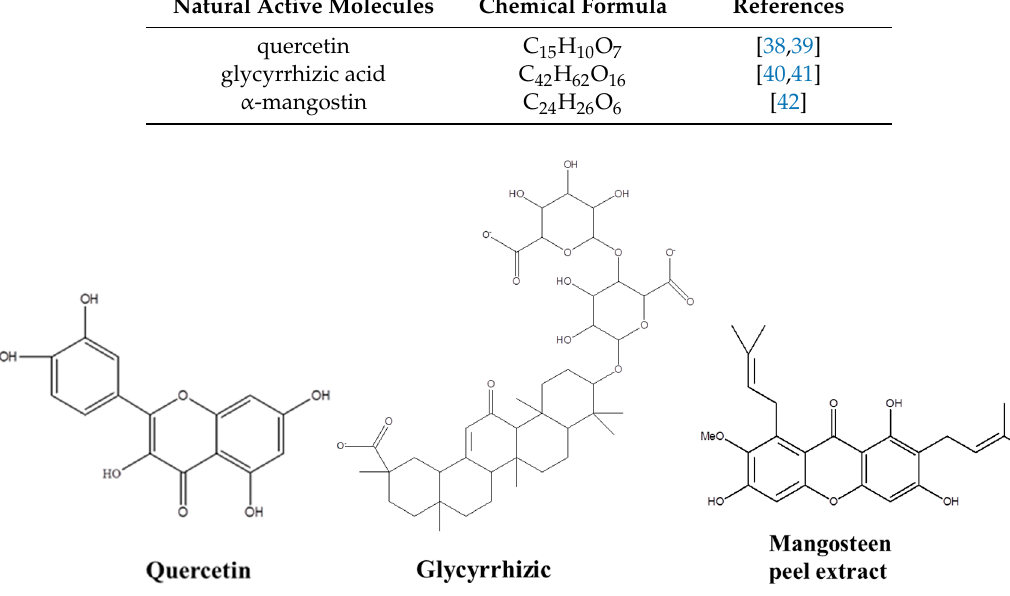
Figure 10. Chemical structure of three active molecules.